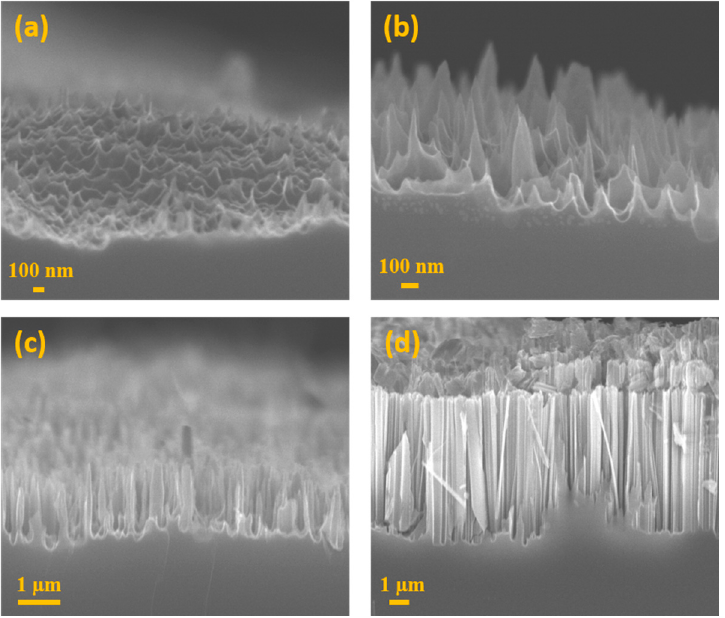
Table 1 . Half solar ‐ to ‐ hydrogen conversion efficiency of various photocathodes.